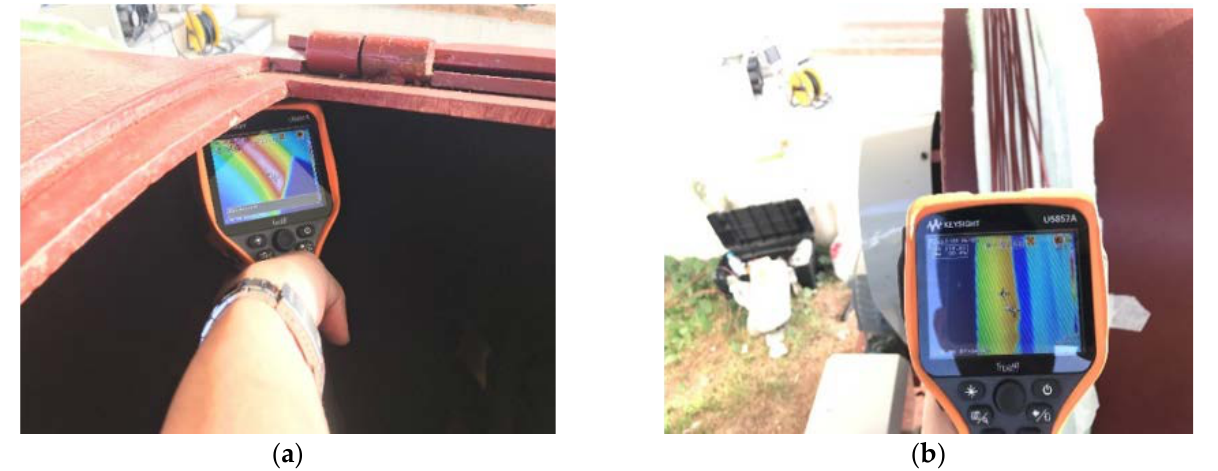
Figure 9. ( a ) The temperature inside the tank in the copper wire area. ( b ) The temperature outside the tank around the copper coil area. After checking that the copper wire wrapped around the large tank, the induction heating machine was used to heat the tank directly. We then wrapped four sets of copper wire around the area to achieve the highest efficiency in direct heating to the tank, as shown in Figure 10.